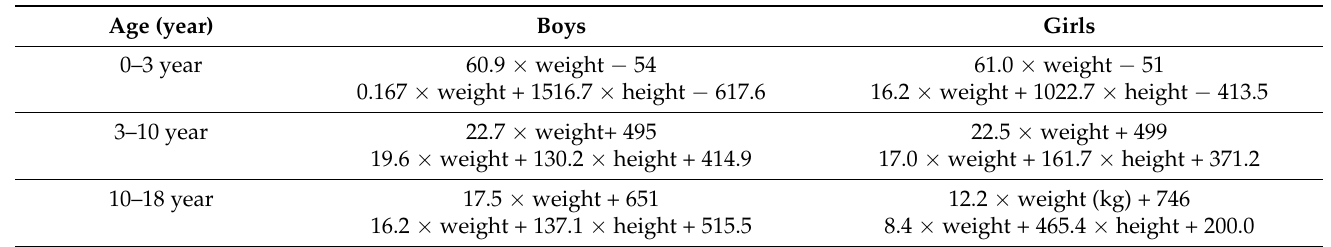
Table 4. The Schofield formulas for estimating resting energy expenditure (REE) from weight (kg) and height (m) in kcal/day *